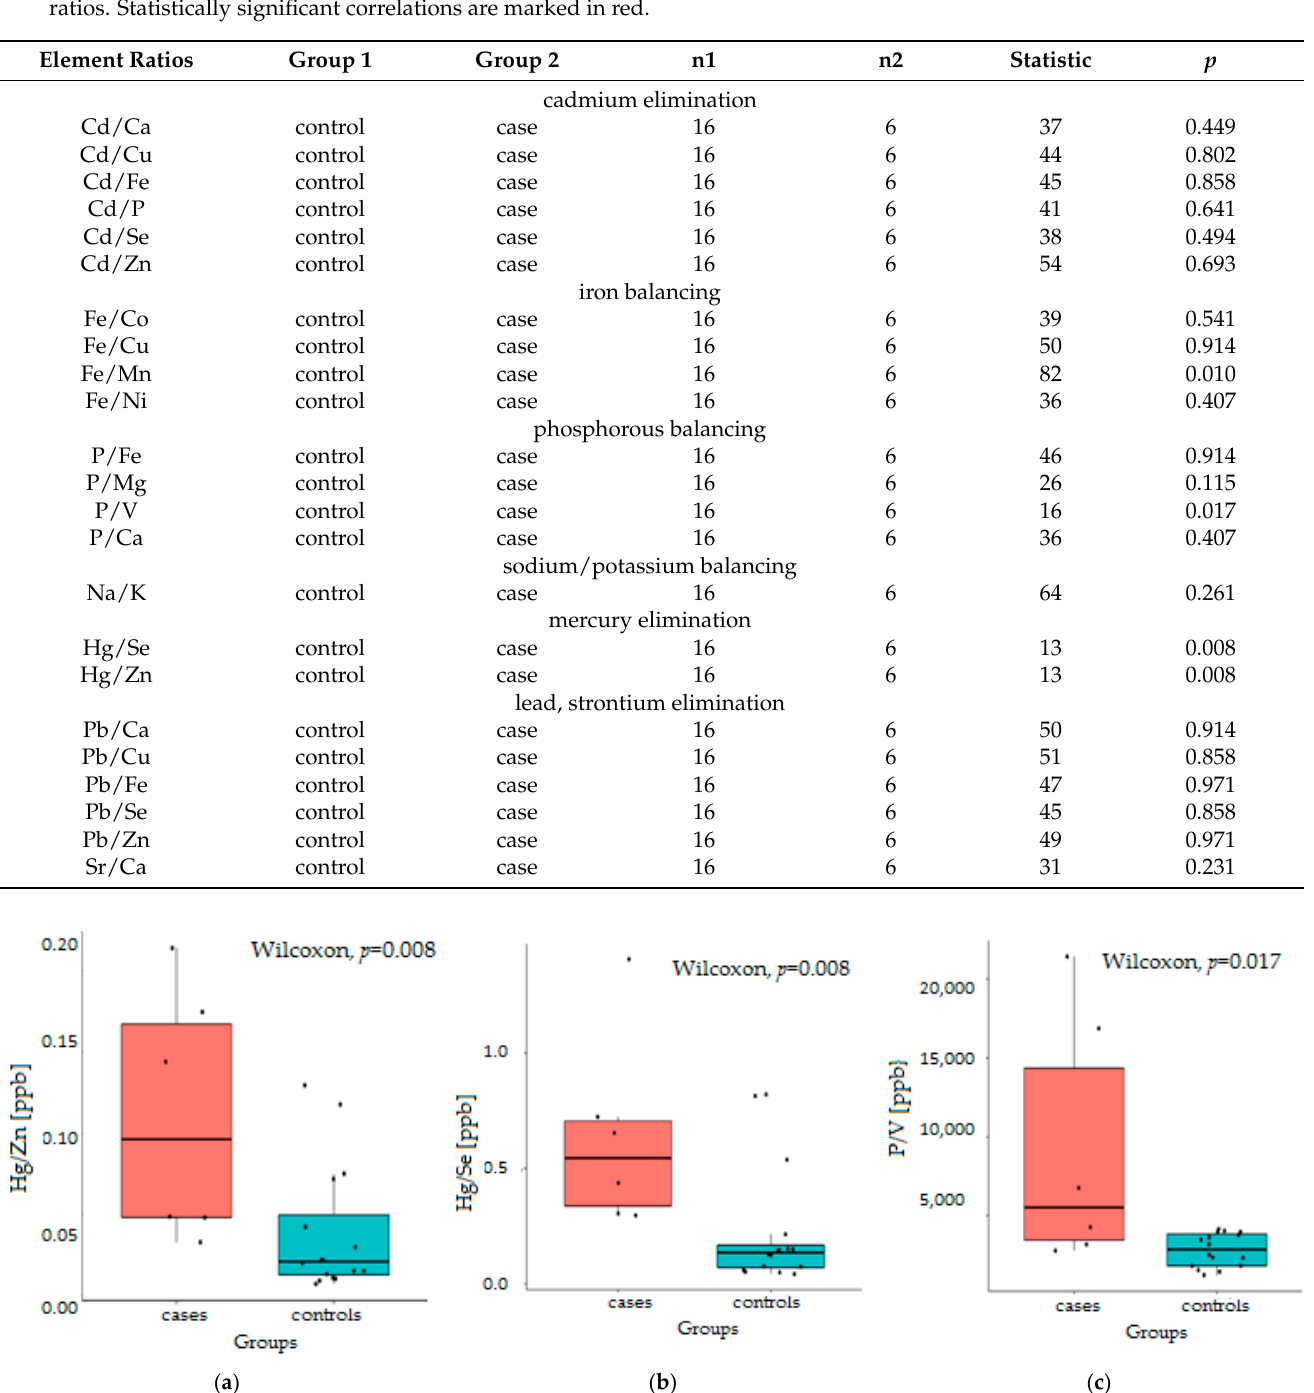
Table 3. Differences between the control (group I, n = 16) and HD patients (group 2, n = 6) considering the selected elemental ratios. Statistically significant correlations are marked in red.